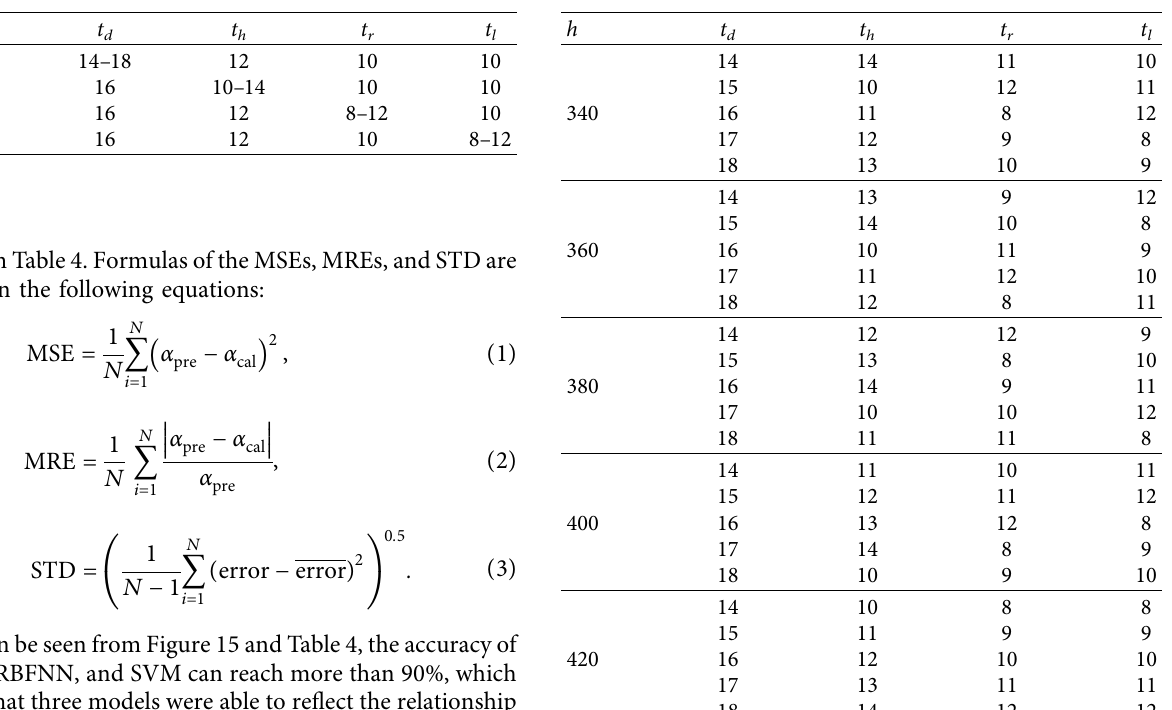
Table 1: Training samples of single factor analysis (unit: mm). Table 2: Samples of orthogonal array method (unit: